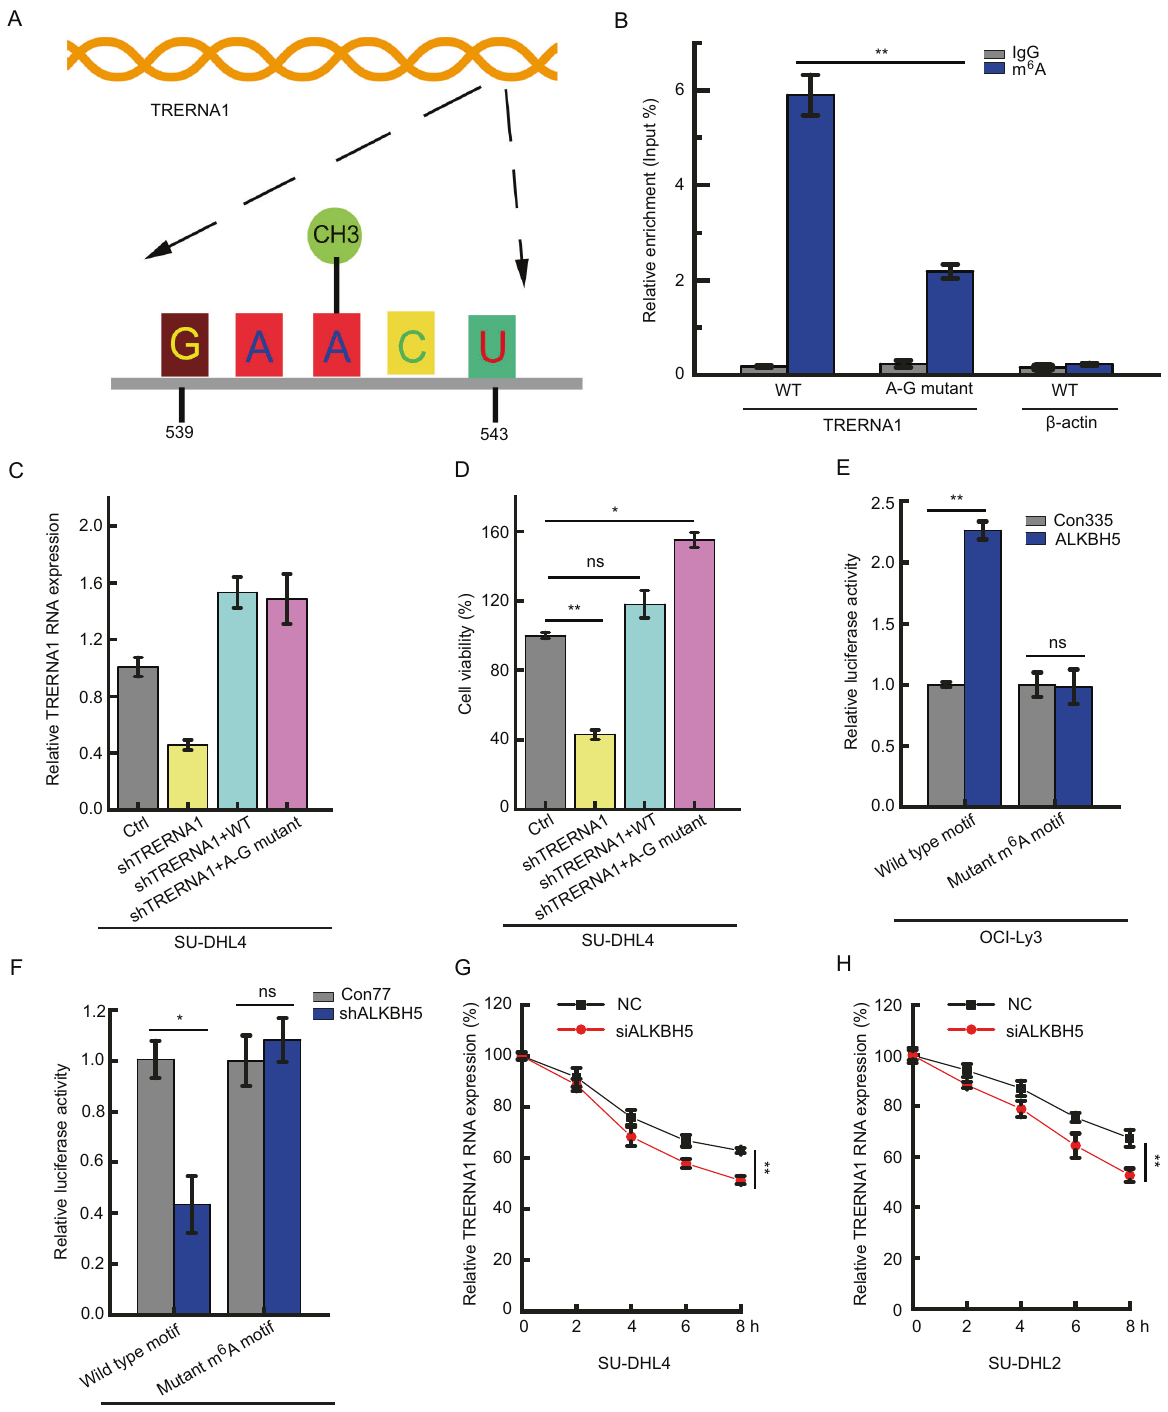
Fig. 4 m 6 A enrichment is negatively associated with TRERNA1 activity in DLBCL. A Schematic representation of the position of m 6 A motifs within TRERNA1. B Changes in m 6 A-modi fi ed TRERNA1 levels between wild-type and mutants in SU-DHL4 cells; A-G mutant, mutant with A-G transition mutations. C TRERNA1 expression in control and shTRERNA1 SU-DHL4 cells in the presence of the indicated overexpression constructs. D Cell viability in the shControl- and shTRERNA1-treated SU-DHL4 cells in the presence of the indicated overexpression constructs. E Relative luciferase activity of TRERNA1 with either wild-type or A – G mutant m 6 A sites after the transfection of OCI-Ly3 cells with LV-ALKBH5. F Relative luciferase activity of TRERNA1 with either wild-type or A – G mutant m 6 A sites after the transfection of SU-DHL4 cells with LV- shALKBH5. G , H TRERNA1 levels in siALKBH5 and control cells were quanti fi ed by qRT-PCR at the indicated time points after actinomycin D treatment. The cells were treated with 5 μ g/ml of actinomycin D at 0, 2, 4, 6, and 8 h. The data are presented as the mean ± SD; n = 3. * P < 0.05, ** P < 0.01. ns nonsigni fi